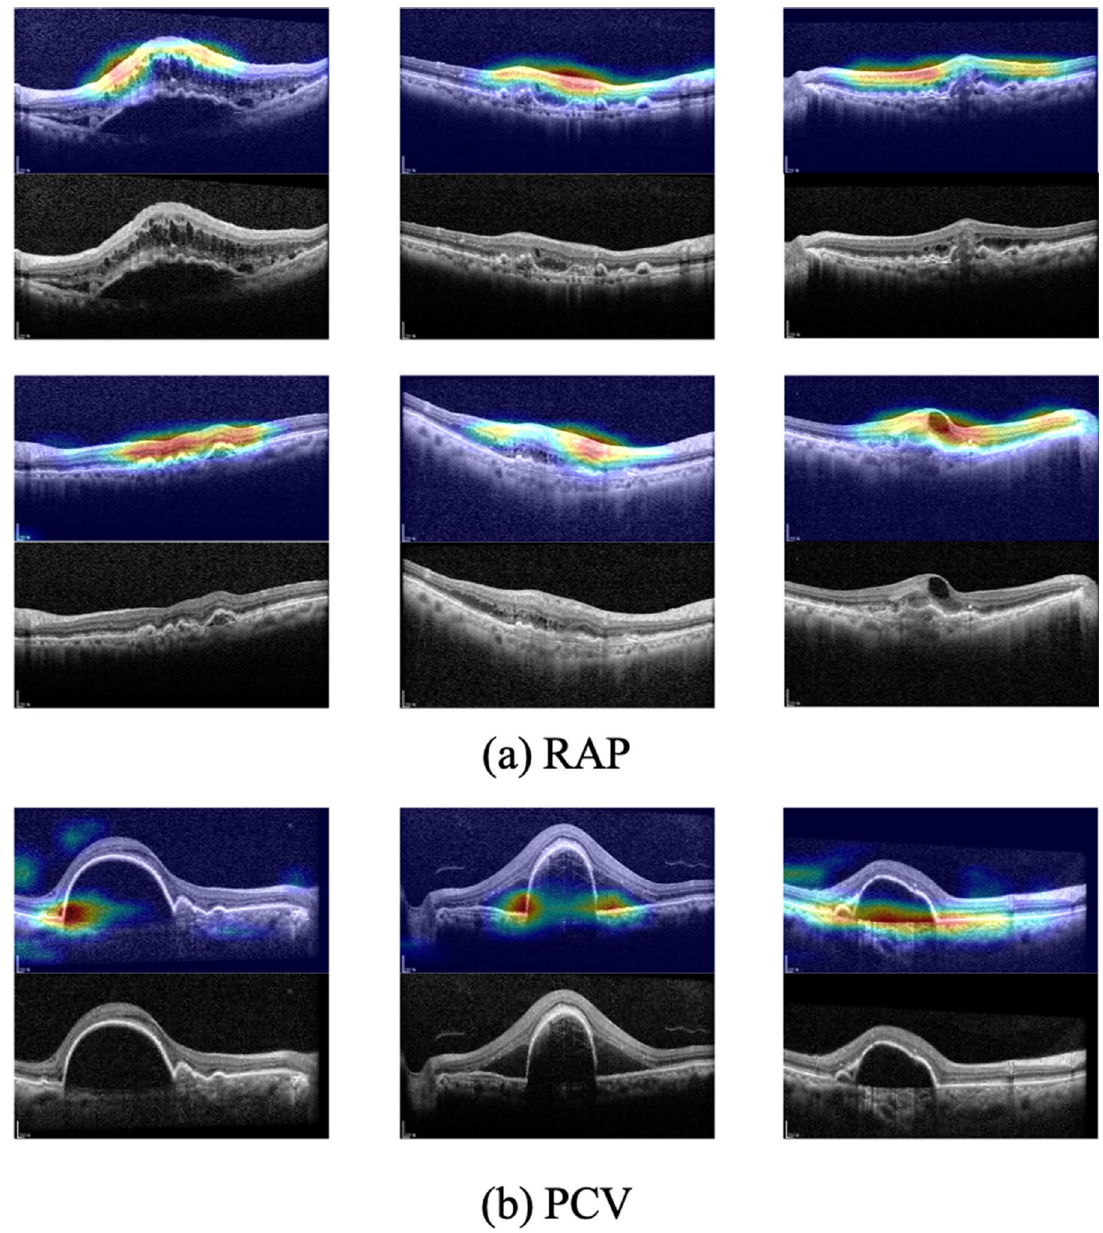
Figure 3. Grad-CAM of the model for six RAP images and three PCV images. The Grad-CAM images display the heat maps of regions used by the model for classifying PCV and RAP images. Grad-CAM was able to identify pathologic regions on the spectral-domain optical coherence tomography images. In PCV cases, Grad-CAM emphasized the sharp edge of the steeper RPED. In one of these PCV cases, the Bruch membrane directly under the RPED was also emphasized. Grad-CAM, gradient-weighted class activation mapping; RAP, retinal angiomatous proliferation; PCV, polypoidal choroidal vasculopathy; RPED, retinal pigment epithelial